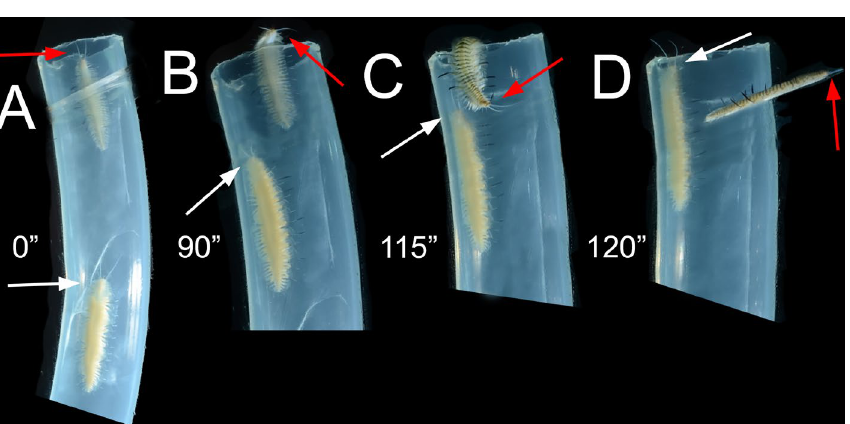
Figure 3. Sequence of a territorial interaction, with resident Ophthalmonoe pettiboneae intimidating an intruder, leading to the latter leaving the tube without being attacked by the former. ( A ) Progressive approach of the resident towards the intruder, with no reaction from the intruder. ( B,C ) Resident still approaching and intruder with part of its body outside the tube. ( D ) Resident at the tube opening and intruder swimming outside the tube. White arrows indicate the resident’s head; red arrows indicate the intruder’s head. Time course indicated in